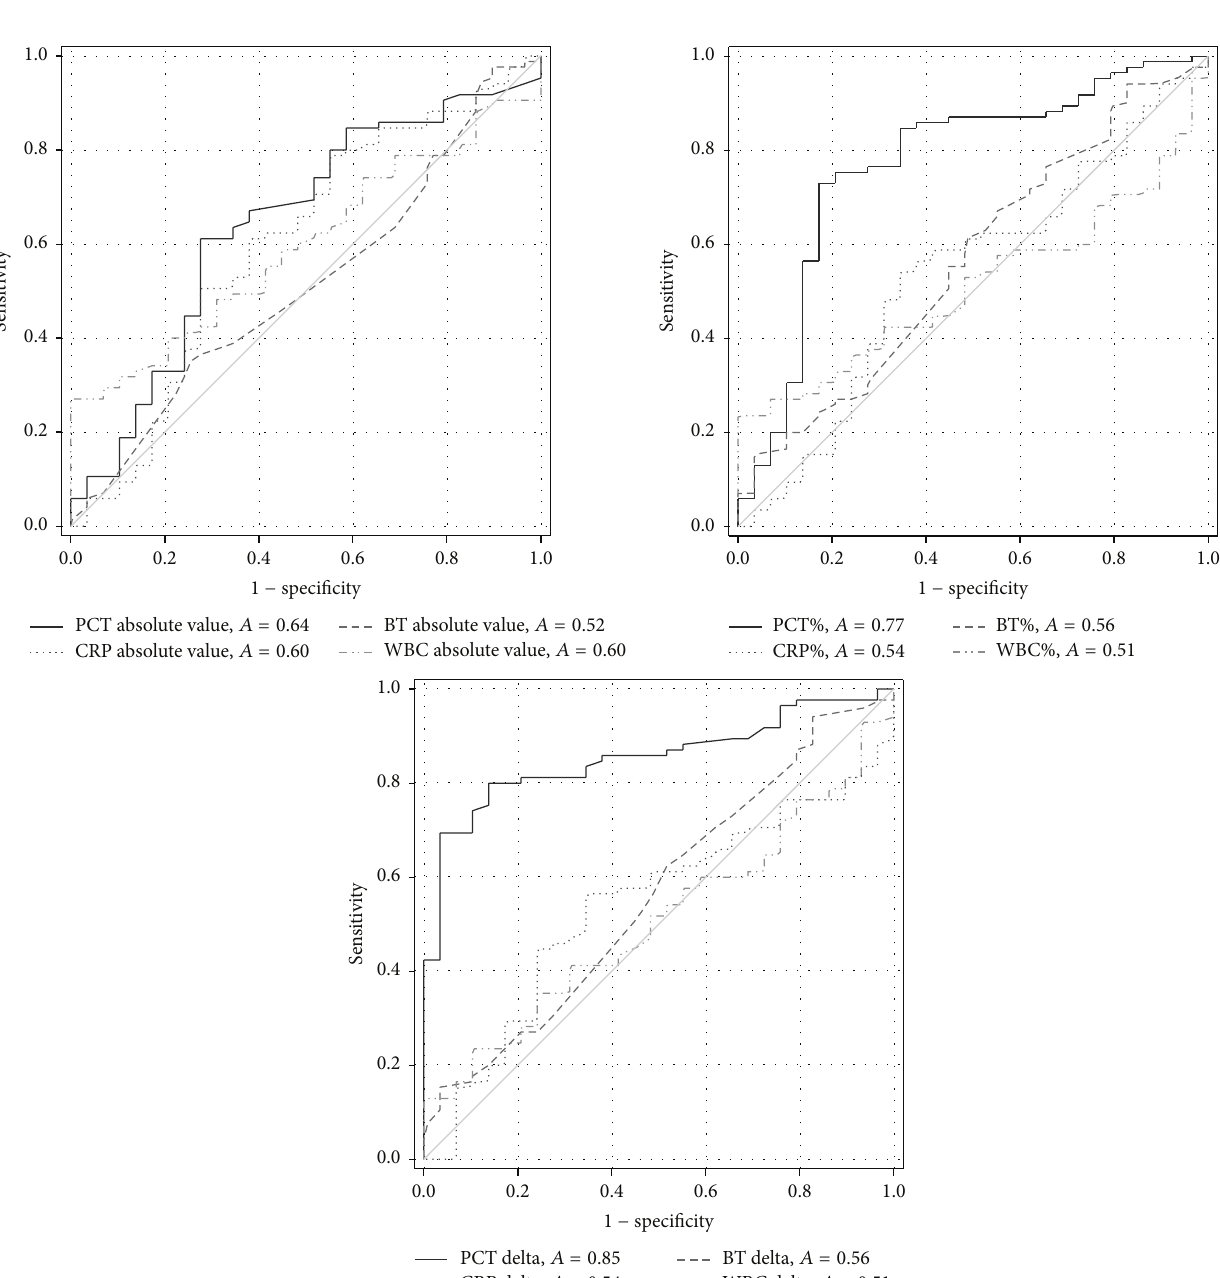
Figure 3: The predictive value of the absolute values, percentage, and delta changes of PCT, CRP, temperature, and WBC count for infection in the total